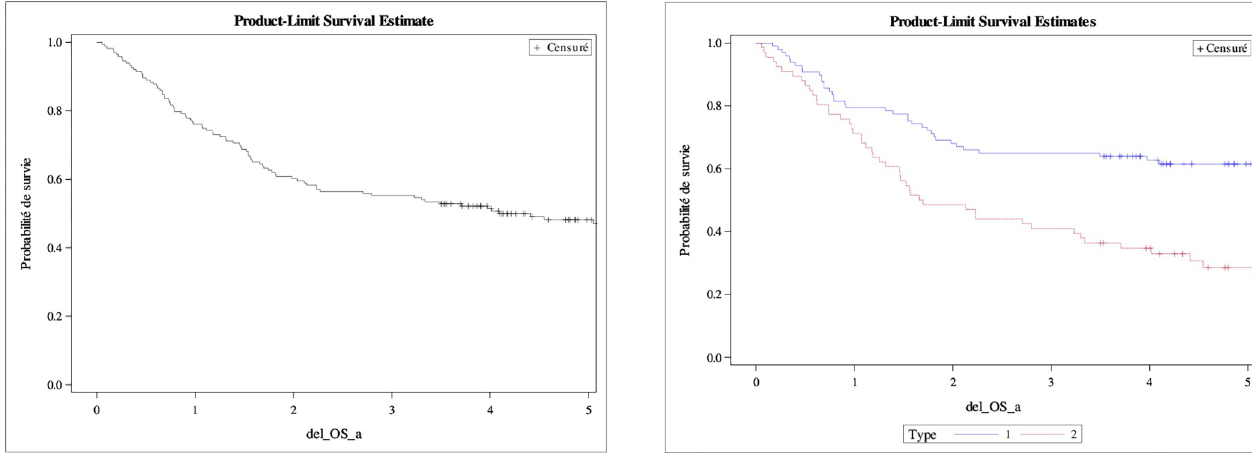
Fig 2. Overall survival (OS) all type, type I and type II. Kaplan-Meier estimates.